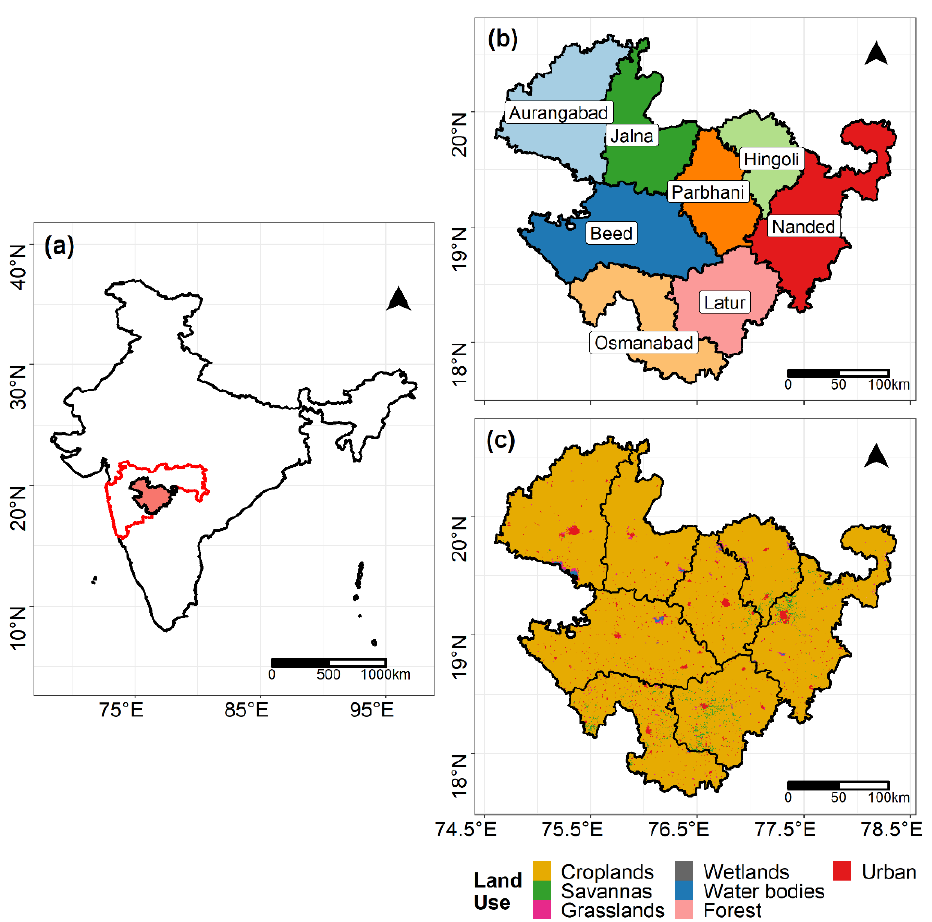
Figure 2. ( a ) Location of the study area. Black and red borders represent India and the state of Maha- rashtra, respectively, while the filled area represents Marathwada region. ( b ) Administrative map of Aurangabad division (Marathwada) with eight districts. ( c ) MODIS land cover product MCD121Q1, International Geosphere-Biosphere Program (IGBP) classification in Marathwada illustrated for the year